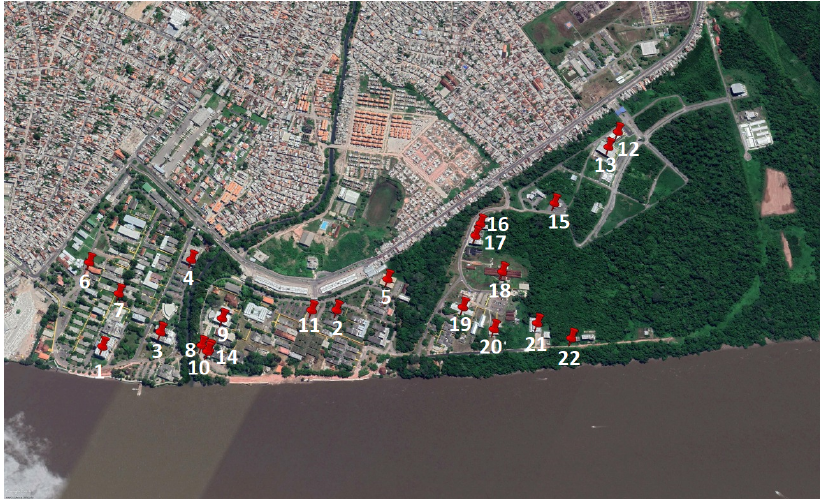
Figure 6. Candidate points for installing the gateways are represented in